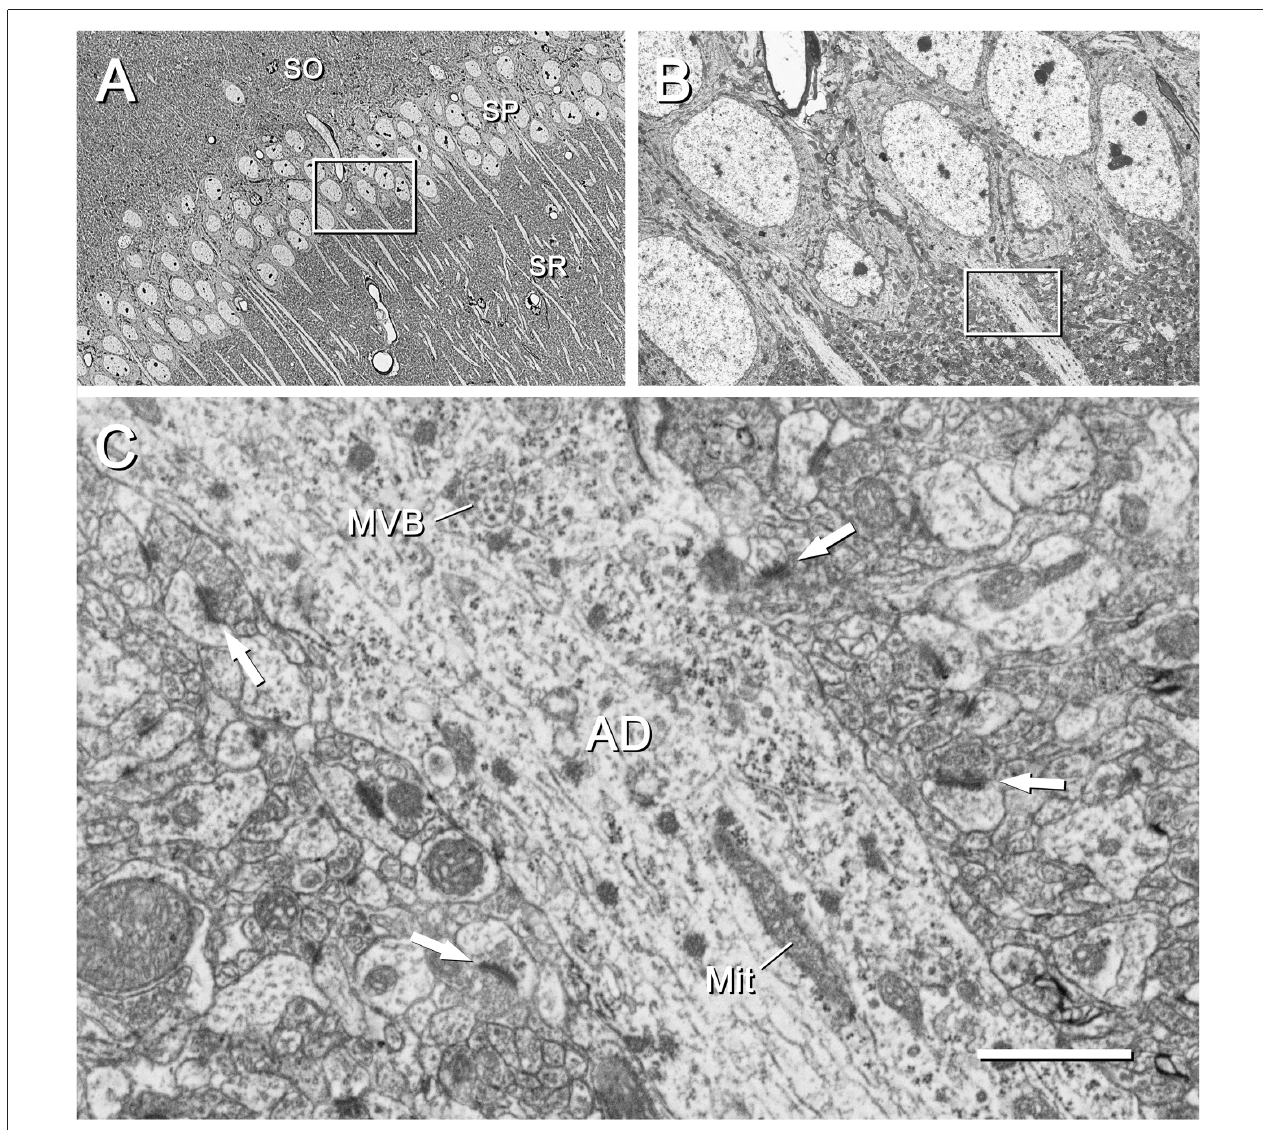
FIGURE 6 | CA1 region of the mouse hippocampus. (A) Area of the CA1 region corresponding to the inset “c” of Figure 2 . The cell bodies and apical dendrites of pyramidal cells are clearly visible. The inset has been further magnified in (B) . SO, stratum oriens; SP, stratum pyramidale; SR, stratum radiatum. The original image was acquired with the SE2 detector at a magnification of 439 × (resolution of 127.2 nm/pixel), with an acceleration voltage of 8 kV. (B) Higher magnification of the stratum pyramidale shown in (A) . The inset on the apical dendrite has been further magnified in (C) . The original micrograph was taken with the SE2 detector at 2500 × (resolution of 22.33 nm/pixel), with an acceleration voltage of 2.2 kV. (C) Apical dendrite (AD) of a pyramidal cell and the surrounding neuropil, as framed by the inset in (B) . Subcellular organelles such as a multivesicular body (MVB) and mitochondria (Mit) are clearly visible. Synaptic junctions in the surrounding neuropil are also visible; some of the postsynaptic densities are marked with arrows. The original image was acquired with the BSE detector at 15,000 × (resolution of 3.72 nm/pixel), with an acceleration voltage of 1.8 kV. Calibration bar: 34 µ m for (A) , 6 µ m for (B) , 1 µ m for (C)